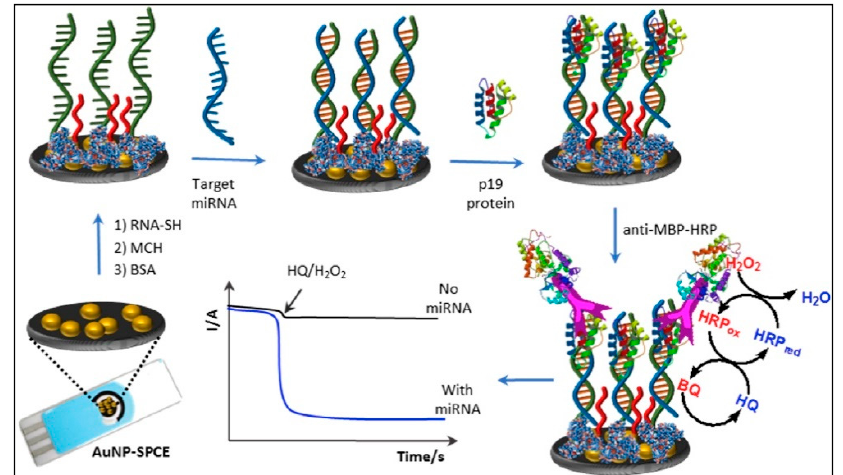
Figure 8. Schematic display of the amperometric integrated sensor developed for miRNA using a specific thiolated RNA probe, a direct RNA / miRNA hybridization assay and p19 viral protein determination using a specific thiolated RNA probe, a direct RNA/miRNA hybridization assay and as detector bioreceptor further labeled with anti-MBP-HRP (reproduced with permission from the p19 viral protein as detector bioreceptor further labeled with anti-MBP-HRP (reproduced with publisher) permission from the publisher) [117].